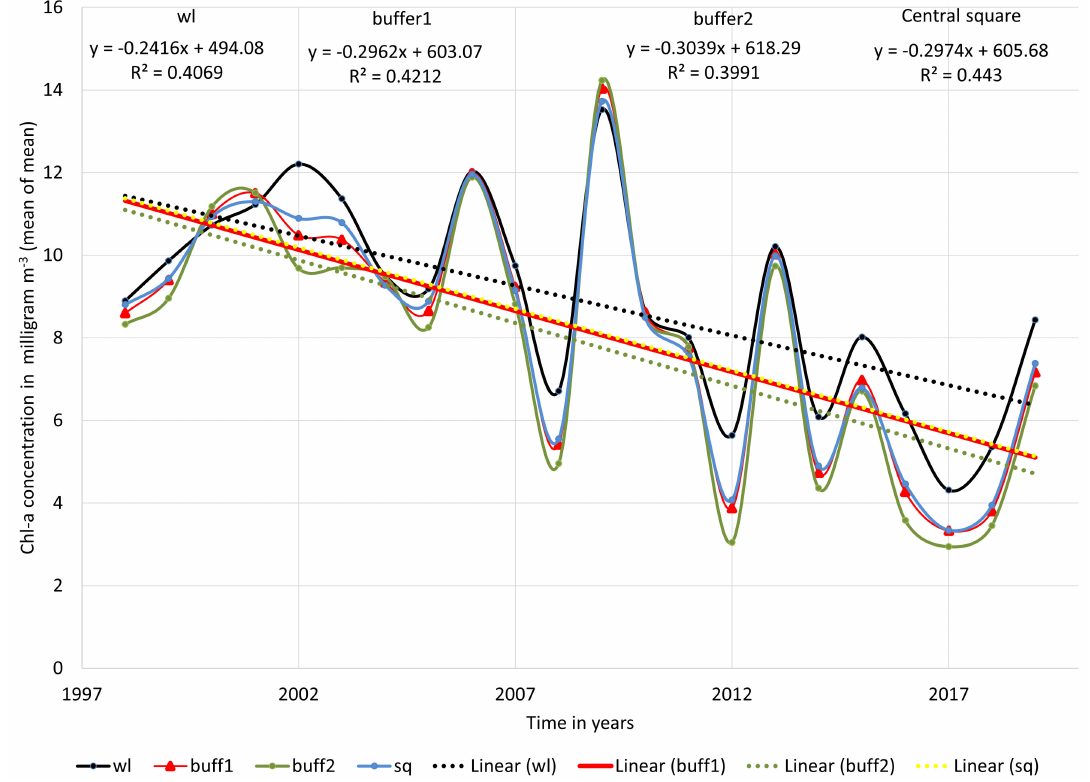
Figure 2. The average seasonal trend of chlorophyll-a concentration (mg m − 3 ) 1998–2019. wl = whole Ladoga lake, bu ff er1 = 12 km from shore line, bu ff er2 = 20 km from shore line, and central square = the sample site in the middle of the